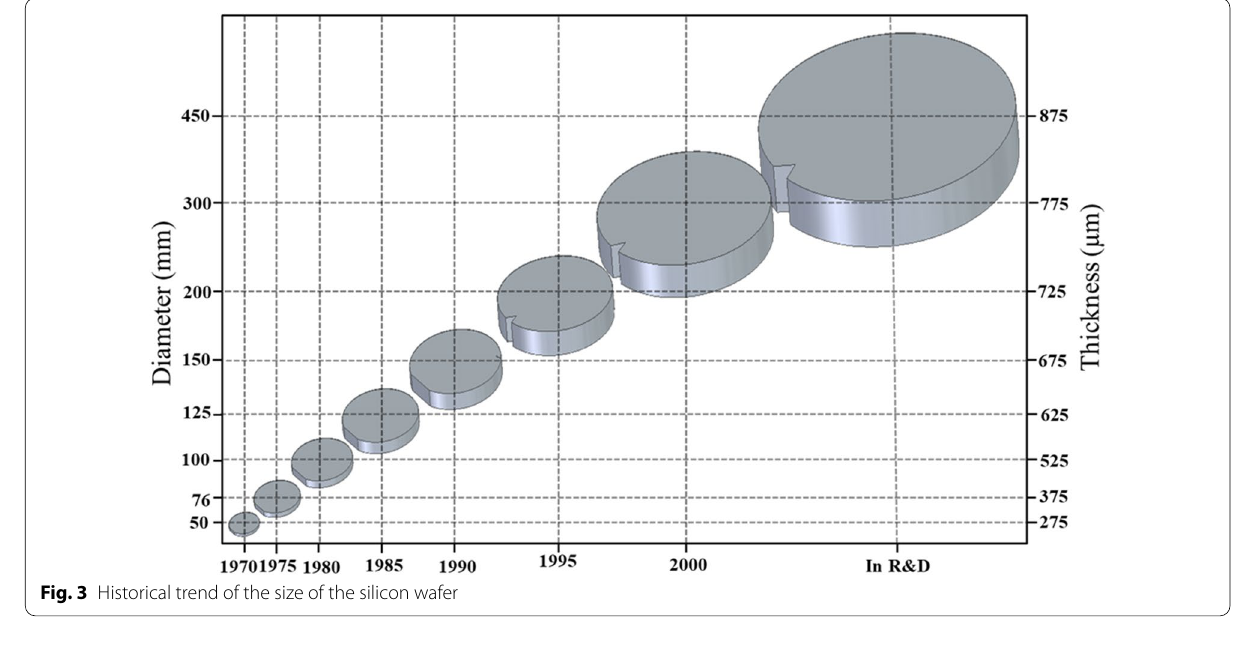
Fig. 3 Historical trend of the size of the silicon wafer